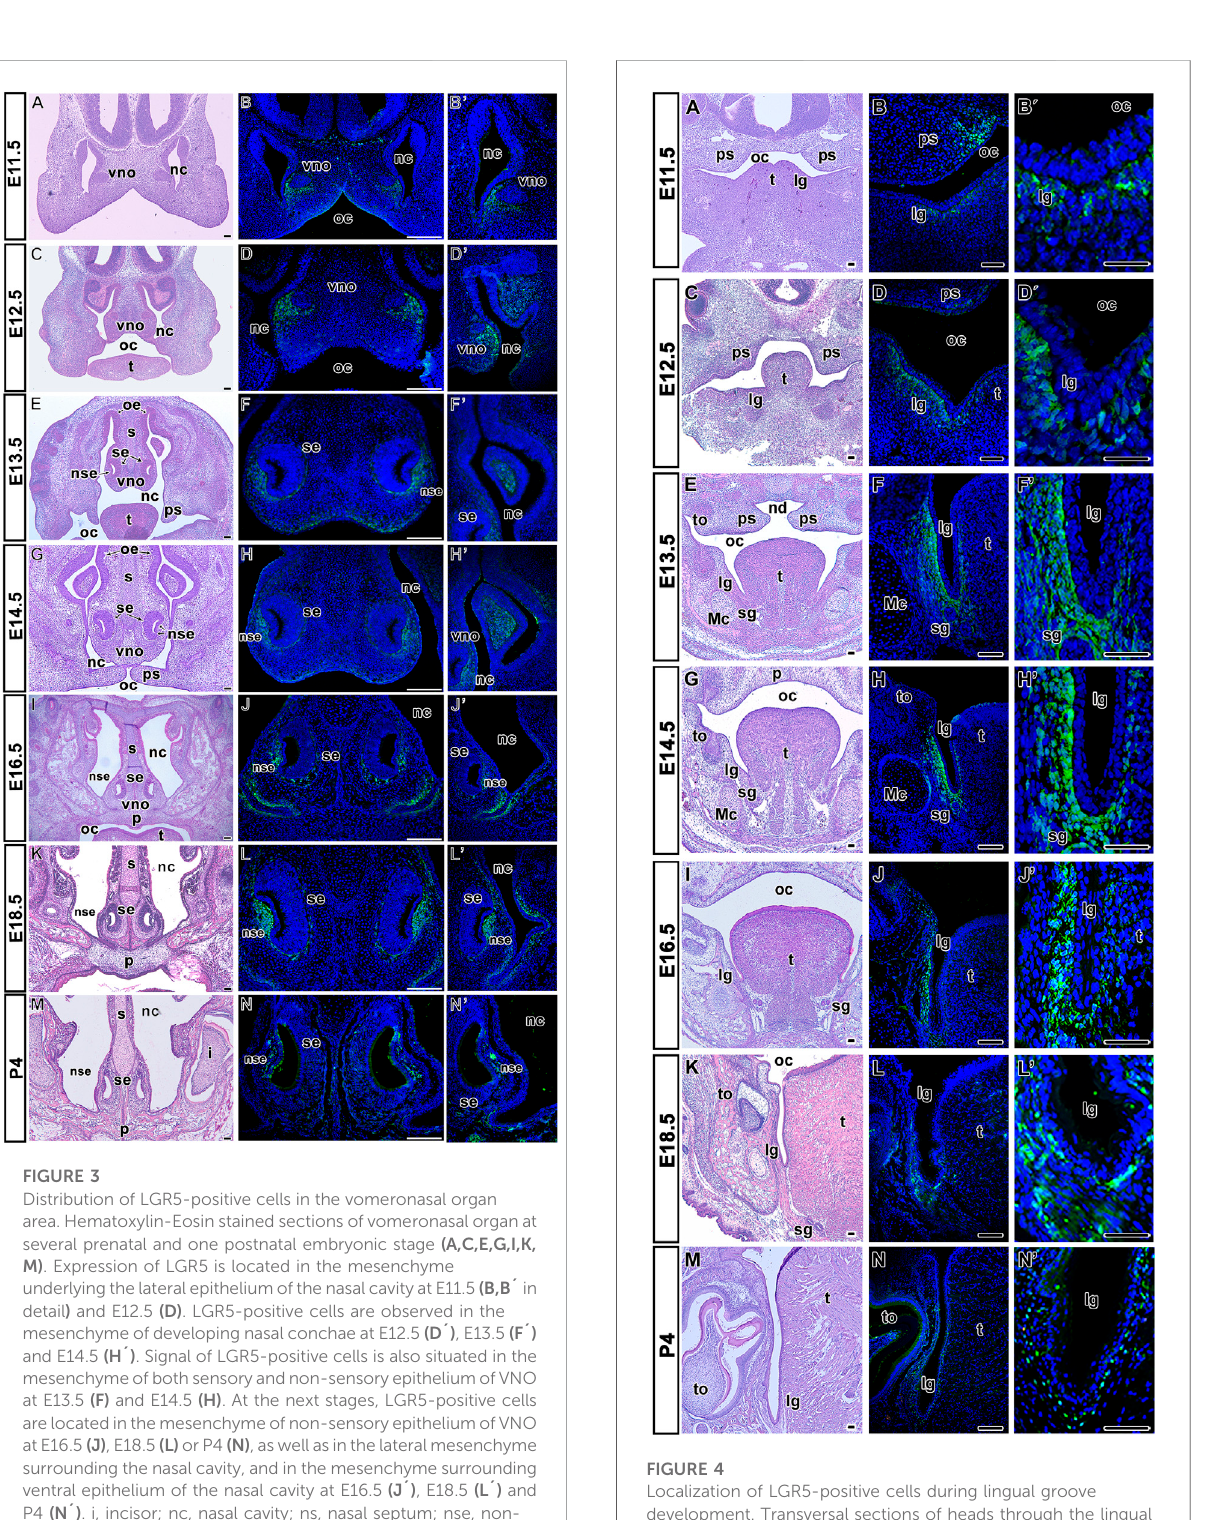
FIGURE 4 Localization of LGR5-positive cells during lingual groove development. Transversal sections of heads through the lingual groove area stained by Hematoxylin-Eosin at several prenatal and one postnatal stage (A,C,E,G,I,K,M) . LGR5-positive cells are situatedinthemesenchymeoflabialandlingualsideofdeveloping grooveatE11.5 (B,B´ indetail ) andE12.5 (D,D´ indetail ) .Population of LGR5-positive cells is situated in the labial and lingual side